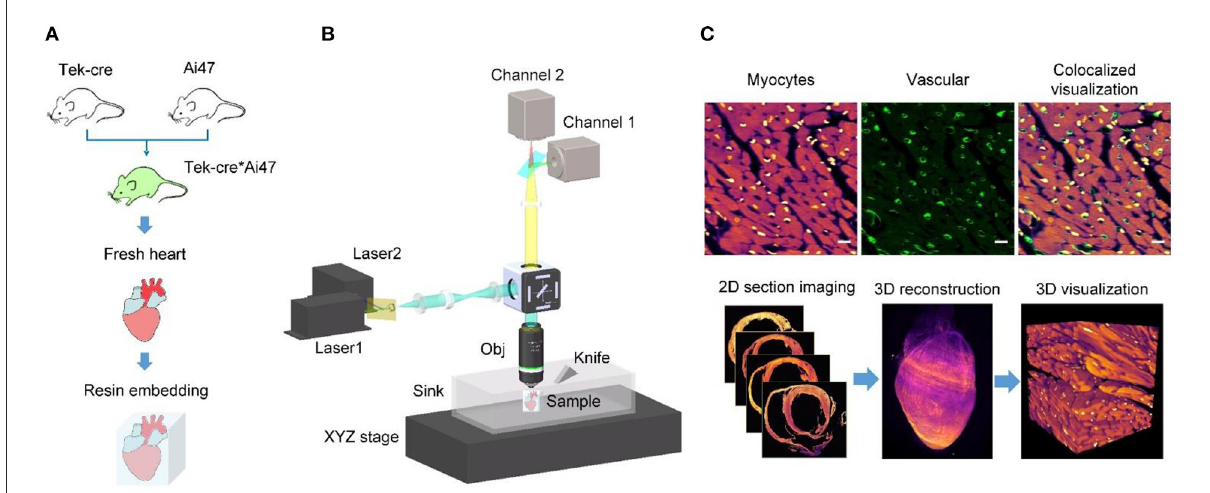
FIGURE1 Single-cell-level heart-wide data acquisition pipeline. (A) Whole-heart sample preparation. We produced vascular fluorescent-labeled transgenic mice (Tek-cre * Ai47) by crossing two transgenic mice (Tek-cre and Ai47), obtained their fresh heart tissues, and embedded them into HM20, a stiff resin. (B) System setup of HD-dfMOST. The system is composed of a line-illumination modulation (LiMo) microscope and a microtome. (Obj, objective lens; sCMOS, scientific complementary metal oxide semiconductors). (C) Cardiac fMOST data were processed and are shown in 2D and